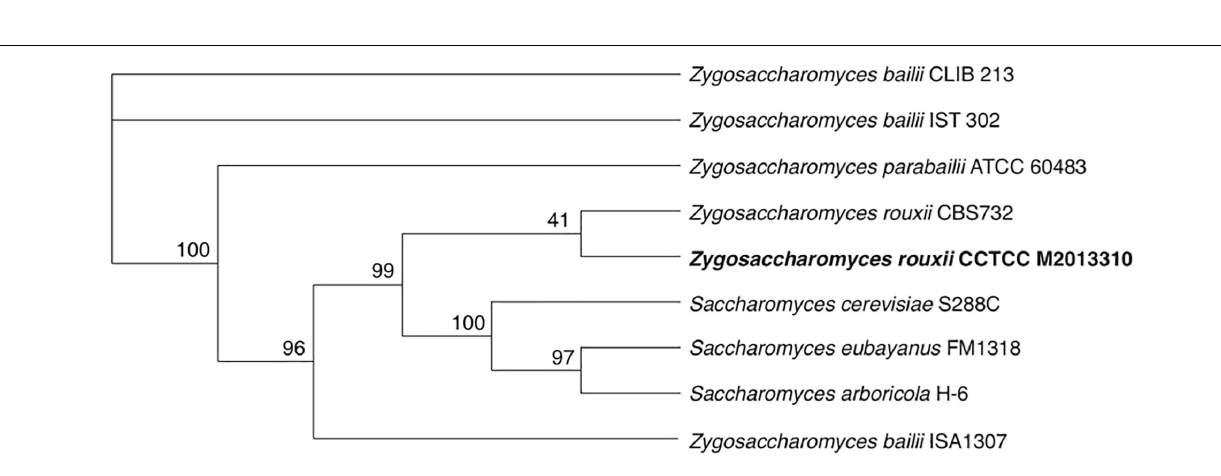
Frontiers in Microbiology | www.frontiersin.org